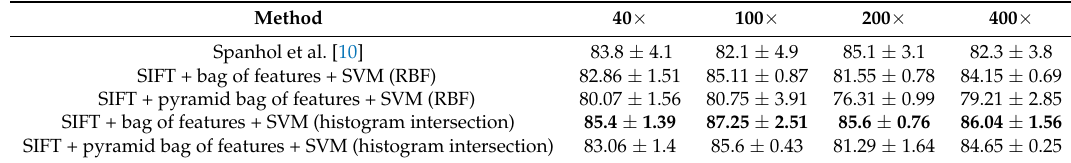
Table 11. Average recognition rate (%) of our proposed method and Spanhol’s method in different magnifications. Bold values indicate the highest average recognition rate in different